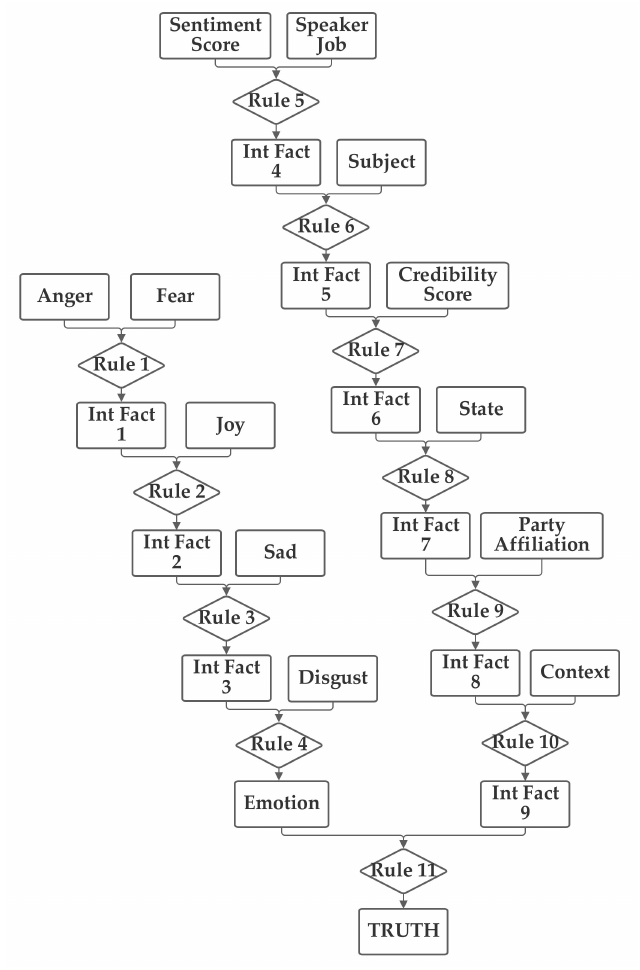
Figure 13. Depiction of Network